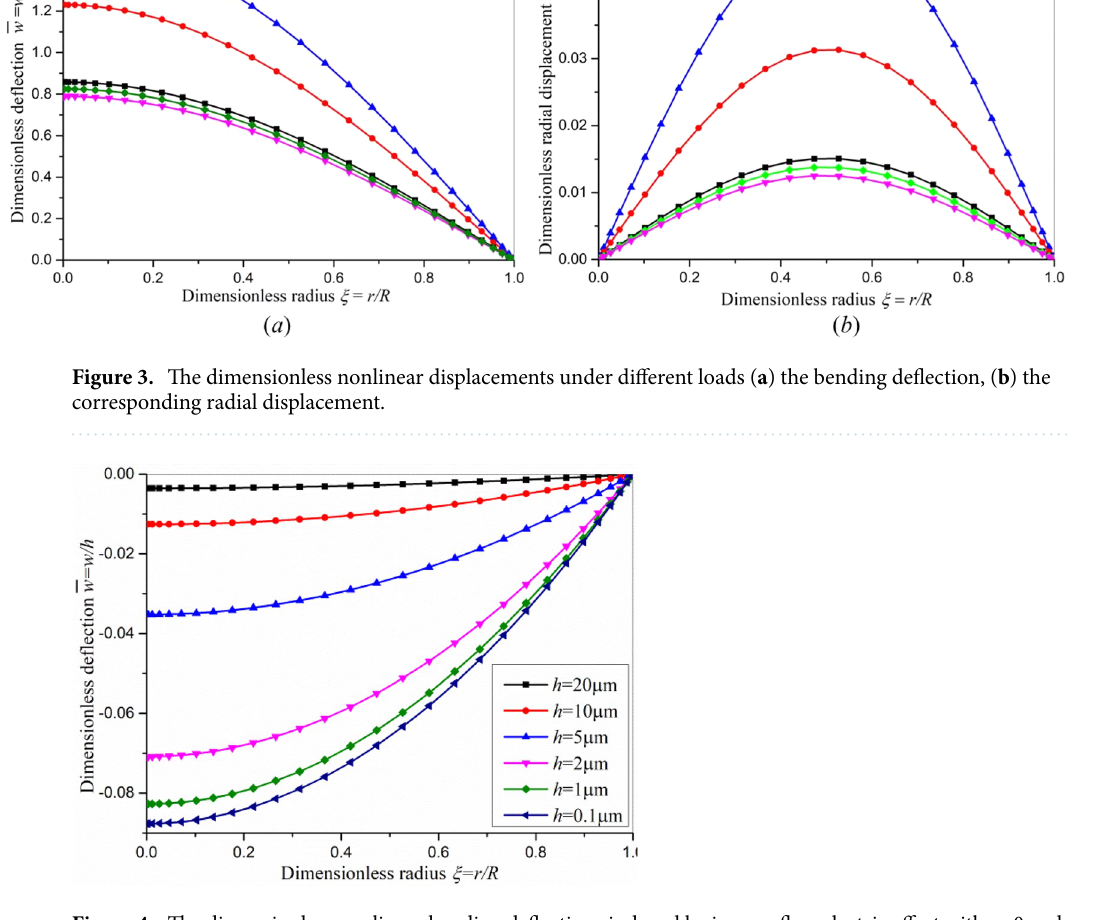
Figure 4. The dimensionless nonlinear bending deflections induced by inverse flexoelectric effect with q =0 and V 0 =1000 V for circular plate of different